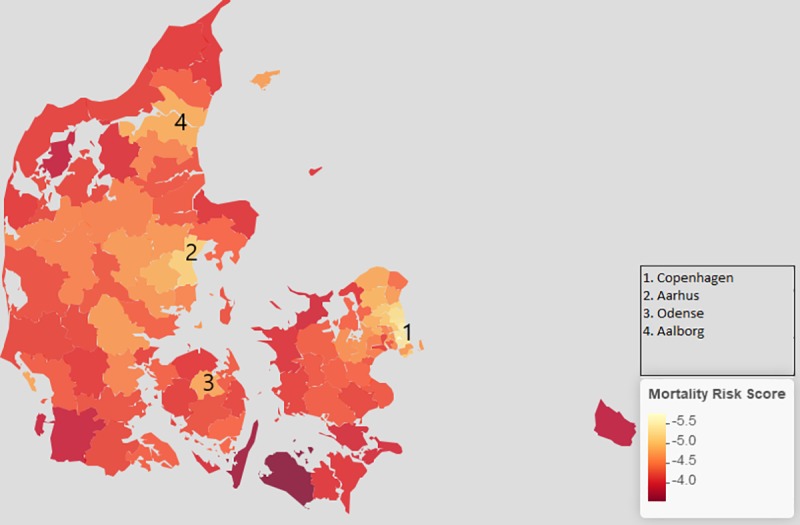
Mean mortality risk score across the 98 municipalities of Denmark–darker colours indicate higher mortality scores.The municipalities containing the four largest cities are marked with numbers 1–4.